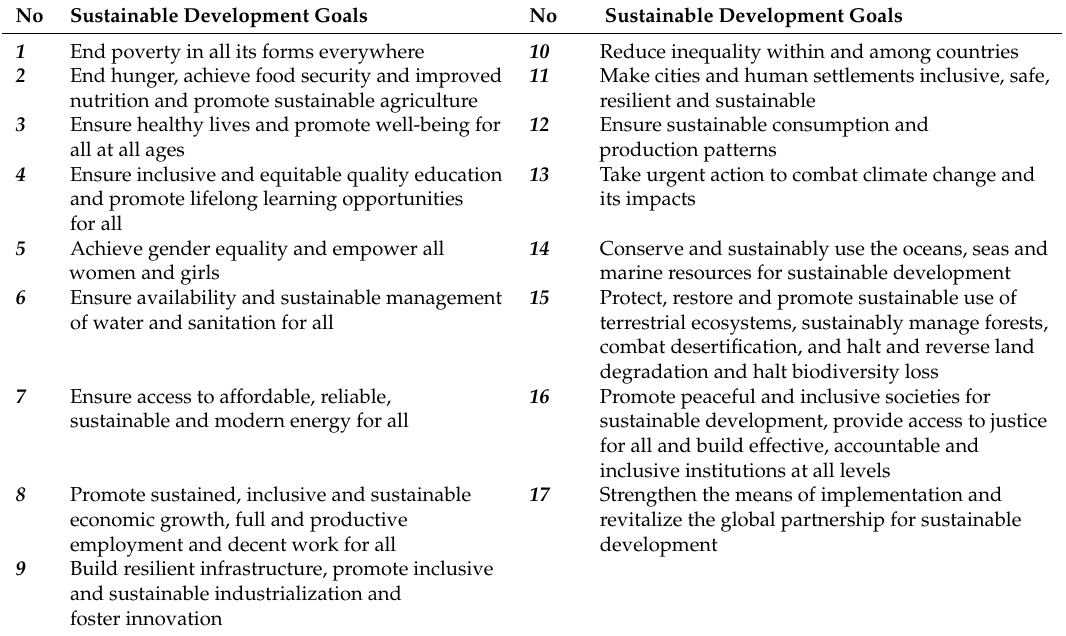
Promising and challenging Seventeen sustainable development goals adopted by United Nations (UN)